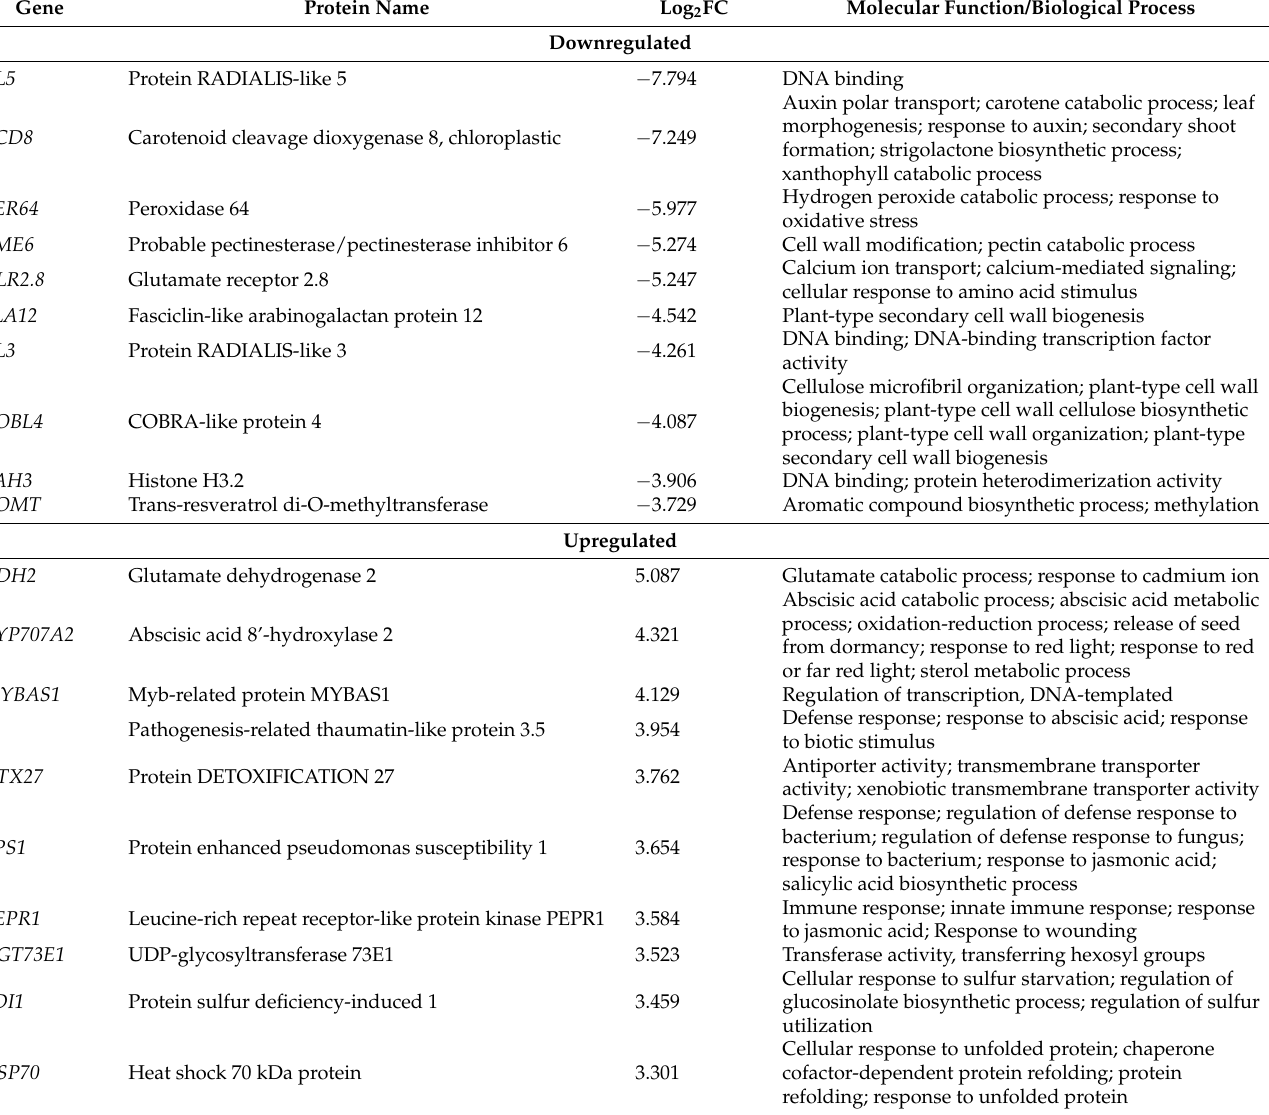
Table 5; Figure S4 vs. Figure S5). Additionally, they were also associated with response to sulphur starvation (GO:0010438), jasmonic acid (GO:0009753) and wounding (GO:0009611), protein transport (GO:0015031), chaperone cofactor-dependent protein refolding, trans- membrane transporter activity (GO:0022857), carbohydrate metabolism (GO:0005975), cell growth (GO:0016049), and lumen of the endoplasmic reticulum (GO:0005788) (Table 5; Figure S5). Table 4. Top 10 most down and upregulated differentially expressed genes (DEGs) in Casuarina glauca nodulated by nitrogen-fixing Frankia casuarinae Thr (NOD + ), grown at 400 mM NaCl relative to the control (0 mM NaCl), ordered by log2 fold-change (log2FC). NBCI gene symbol, protein name, log2FC and respective Gene Ontology (GO) molecular function(s) and biological process(es) retrieved from UniprotKB database. Protein names coloured in blue are also among the top 10 most down or upregulated DEGs, respectively, at 400 mM NaCl in non-nodulated plants supplied with KNO 3 (KNO 3+